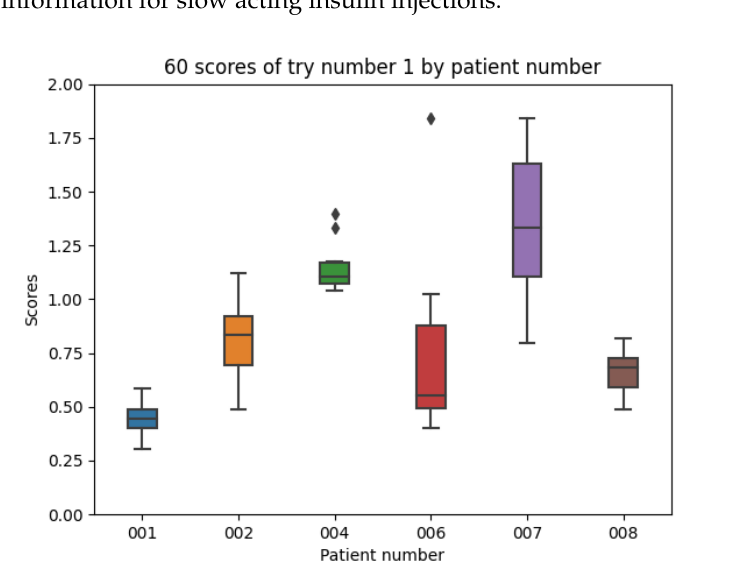
Figure 12. Experiment 1 boxplot scores, from 10 executions for each patient and configuration. It shows that the best results are with patient 001 and the worst with patient